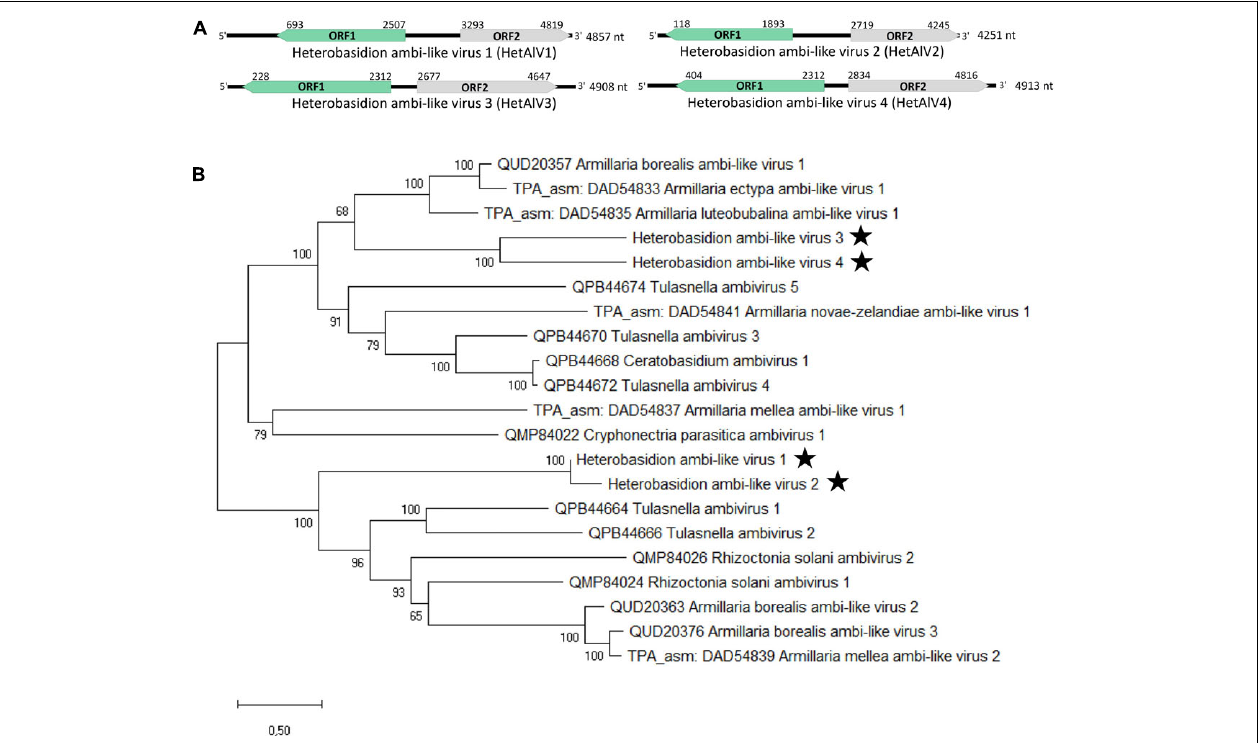
FIGURE 4 | Genome organization and phylogenetic analysis of Heterobasidion ambi-like viruses 1–4 (HetAlV1–4). (A) Schematic presentation of HetAlV1–4 genomes with UTRs and predicted ORFs with translation initiation and termination sites. Green-colored ORFs represent the putative RdRPs. (B) Phylogenetic tree of the ambi-virus like viruses. The predicted aa sequences of putative RdRPs were aligned in MEGA X (Kumar et al., 2018) with MUSCLE and tree was constructed with the LG (+F) model with G+I rates among sites (best-fit model according to ModelFinder) and 500 bootstrap repetitions. All positions with less than 95% site coverage were eliminated, i.e., fewer than 5% alignment gaps, missing data, and ambiguous bases were allowed at any position. The Heterobasidion ambi-like viruses are designated with a